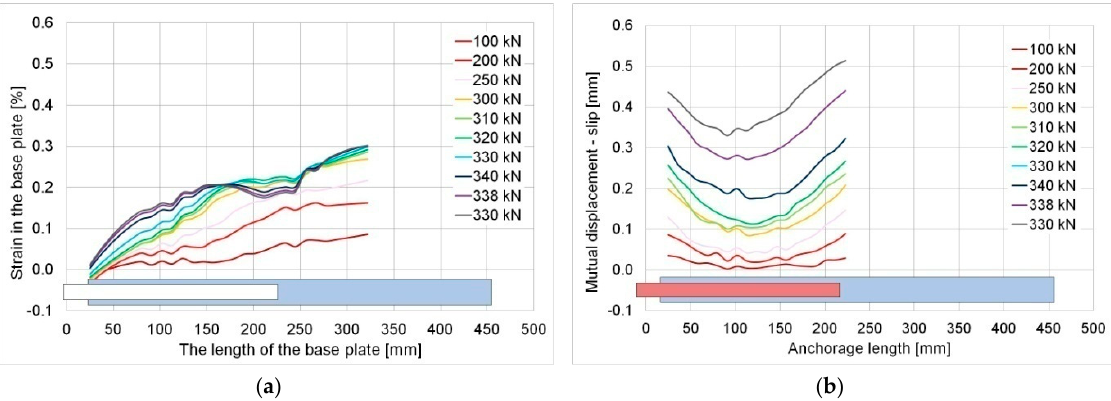
Figure 16. Specimen S/DL/MA/RS-200-4/P2: ( a ) Strain measured in the basic plate, ( b ) calculated slip between the overlap and basic plate.